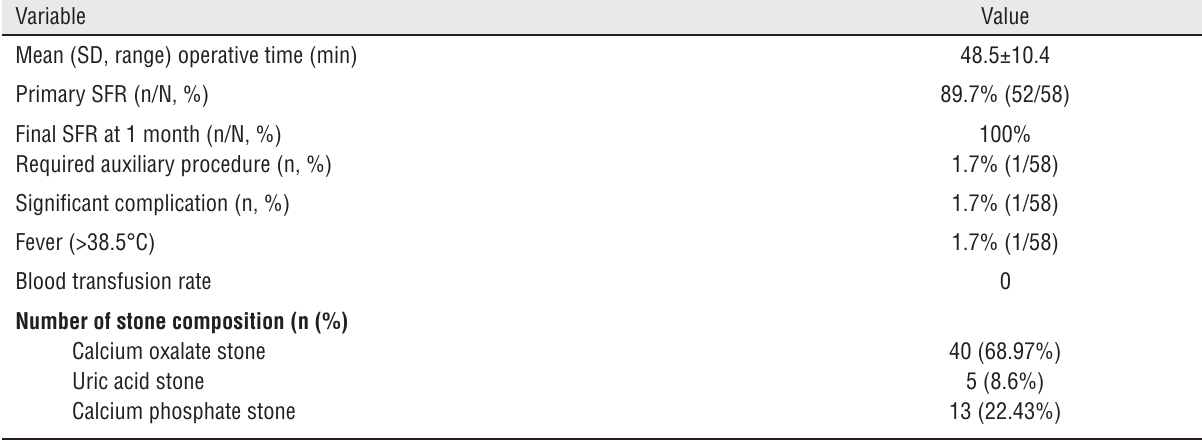
Table 2 - Intraoperative and postoperative